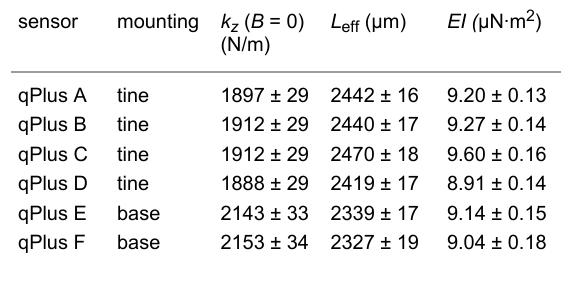
Table 2: Mechanical characterization of qPlus sensors with nanoin-